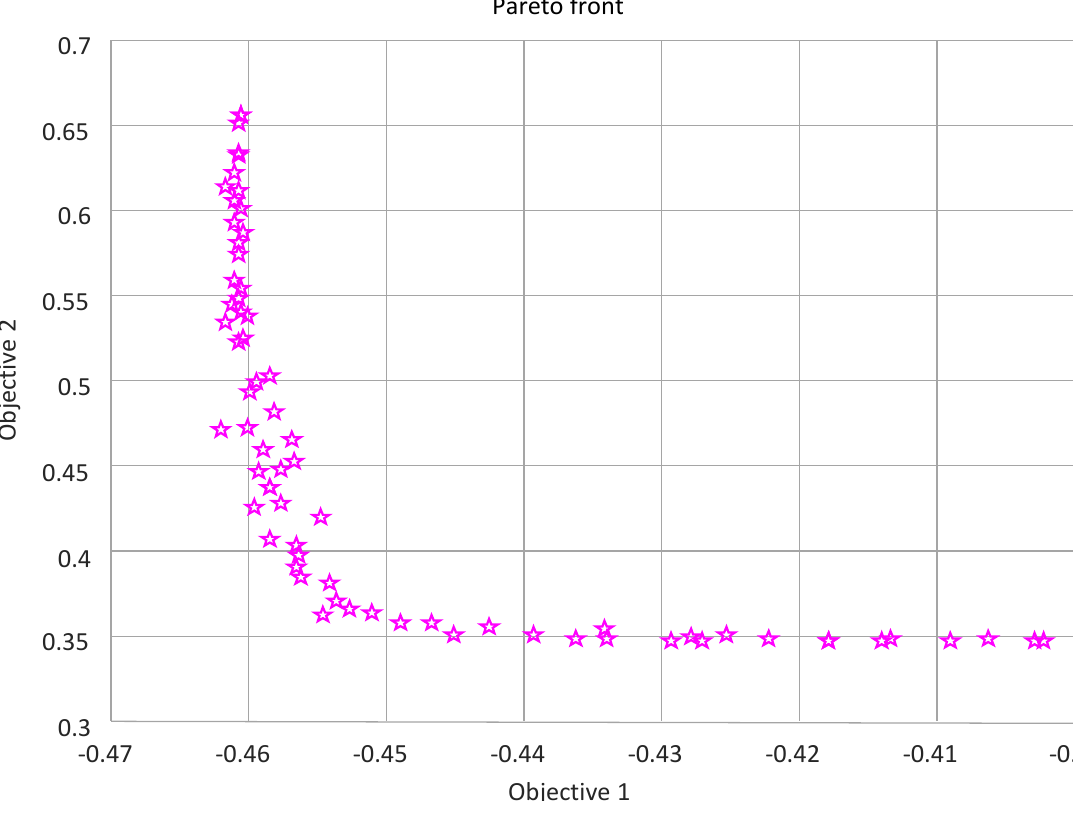
Figure 3. Results of calculations of multi-objective optimization problem of determination of optimal values of indicators and levels of development of export-import activity of PAT